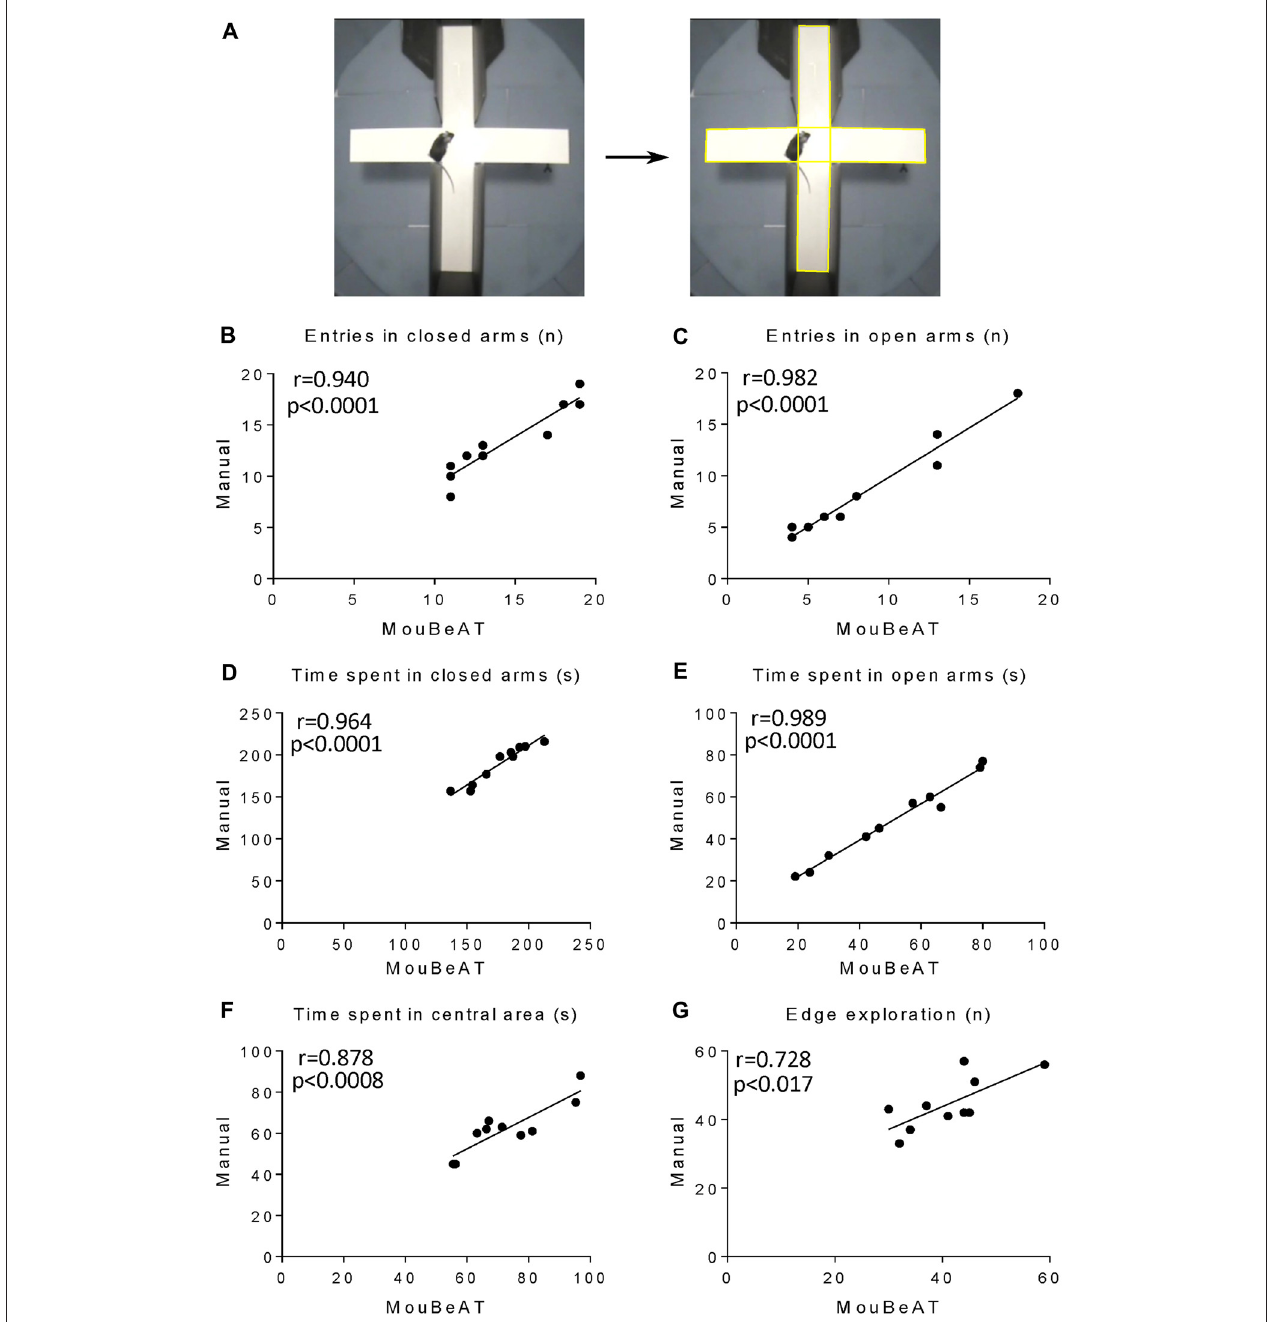
FIGURE 3 | Correlation of results for the Elevated Plus Maze (EPM) obtained by MouBeAT and manual observation. The EPM test (A) was performed on 10 C57BL/6J male mice. Yellow ROIs defines the central region and edges of the maze. Each dot represents the number of entries in closed (B) and open (C) arms, time spent in closed (D) and open (E) arms, time spent in central area (F) and times of over the edge exploration (G) for each mouse.